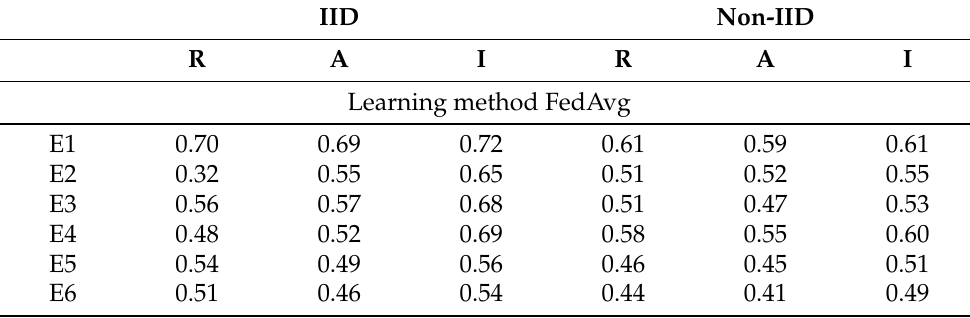
Table 10. Classification accuracies for dataset cardiotocography.